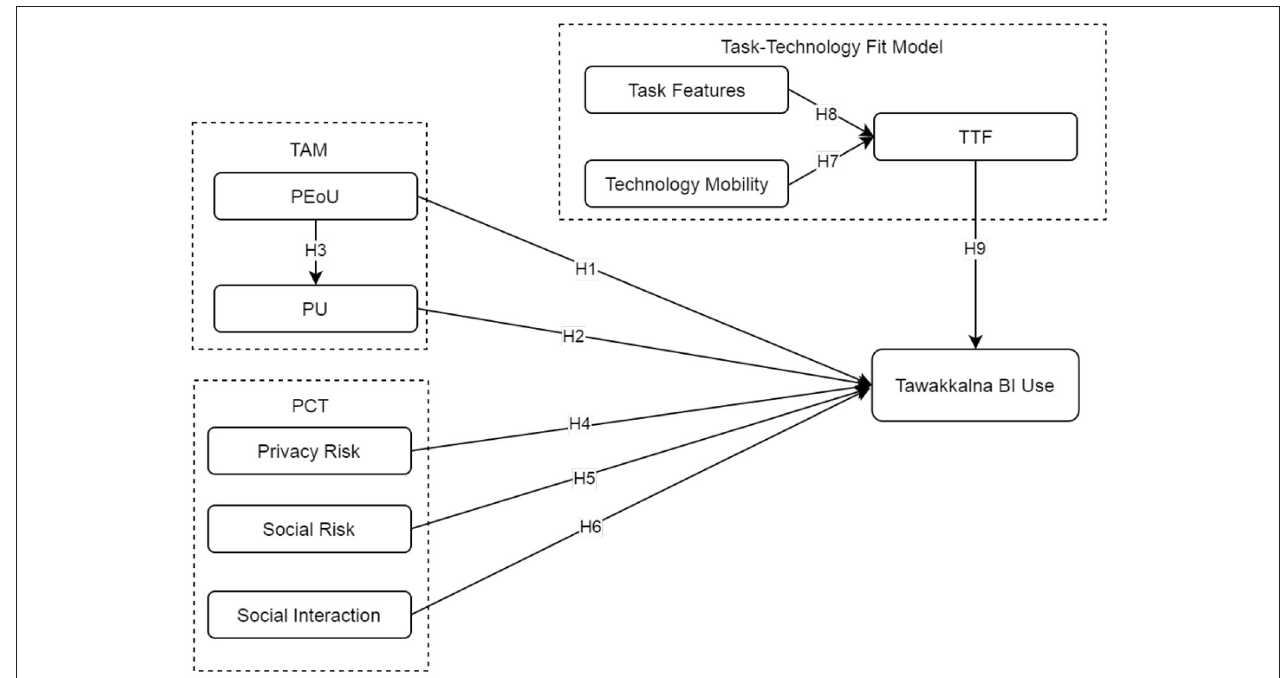
FIGURE 2 | Research model for adoption of Tawakkalna contact-tracing app (CTA). BI, behavioral intention; PCT, privacy calculus theory; PEoU, perceived ease of use; PR, privacy risk; PU, perceived usefulness; SI, social interaction; SR, social risk; TAM, technology acceptance model; TF, task features; TM, technology mobility; TTF, task-technology